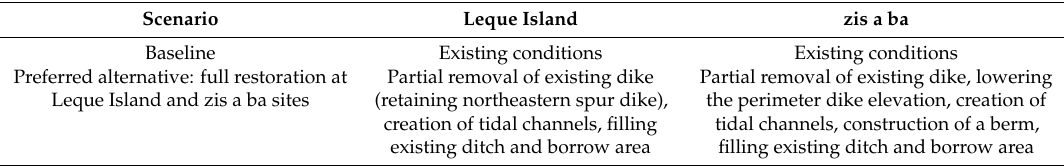
Table 1. Descriptions of the model scenarios at the Leque Island and zis a ba